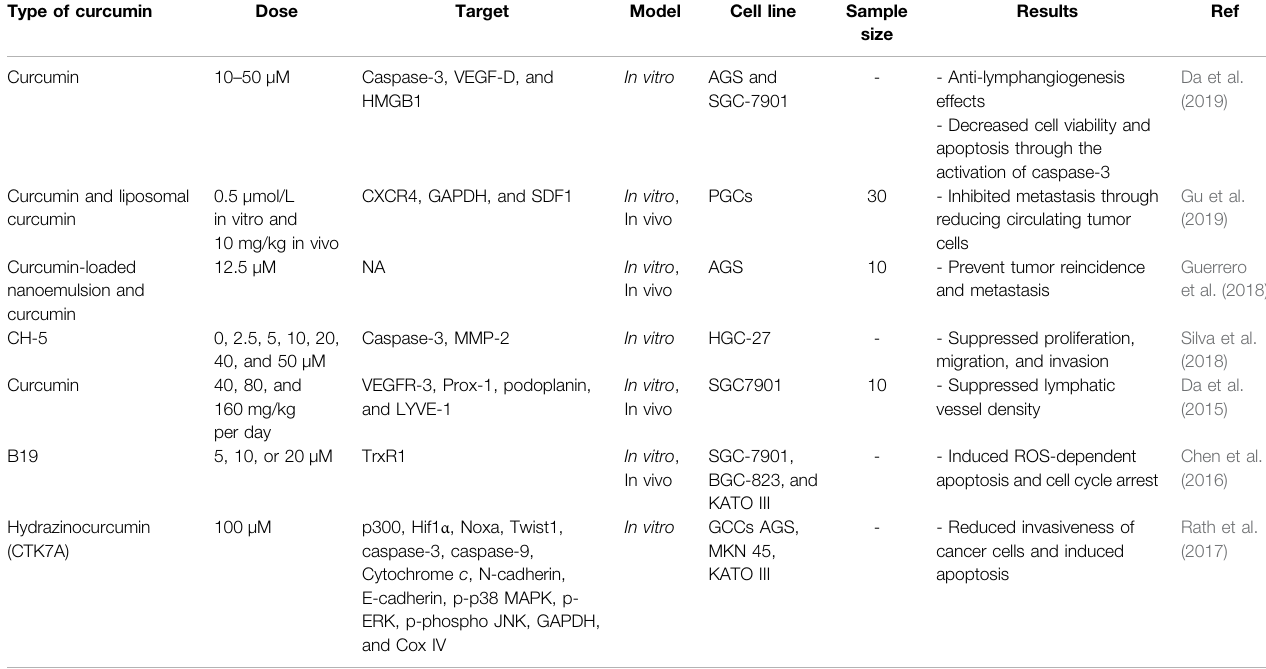
TABLE 2 | Curcumin inhibits gastric cancer